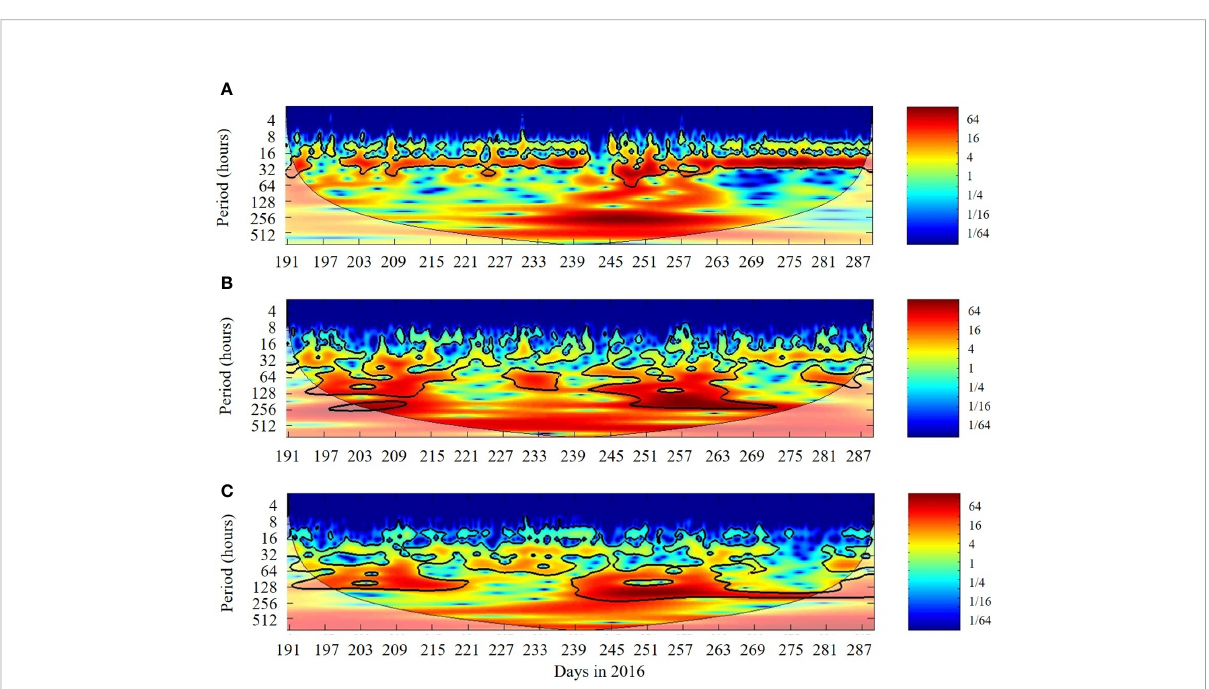
FIGURE 4 Wavelet power spectrum of CO 2 fl uxes (A) , windspeed (B) and water pressure anomaly (C) for the period spanning from July up to November 2016. The contours are for variance units. The 5% signi fi cance level against red noise is shown as a thick contour (cone of in fl uence). Blurred regions indicate values outside the cone of in fl uence. The 95% signi fi cance level is shown by heavy black contours. The horizontal scale represents the Julian days in July-November 2016 period. The results of the cross-wavelet analysis for the winter-spring (Figure 5) and summer-fall periods (Figure 7) are presented as the common power (energy) spectrum of the two-time series or the wavelet coherences that emphasize the correlations between variations of two series, i.e., coherence fl uctuations. The analysis indicates the local correlation (0 ≤ r ≤ 1) of signi fi cant oscillations observed between the CO 2 fl uxes and windspeed and water pressure anomaly. The relative phase between the variables is presented as vectors: they point toward the right (left) at the horizontal when the variables are totally in phase (out of